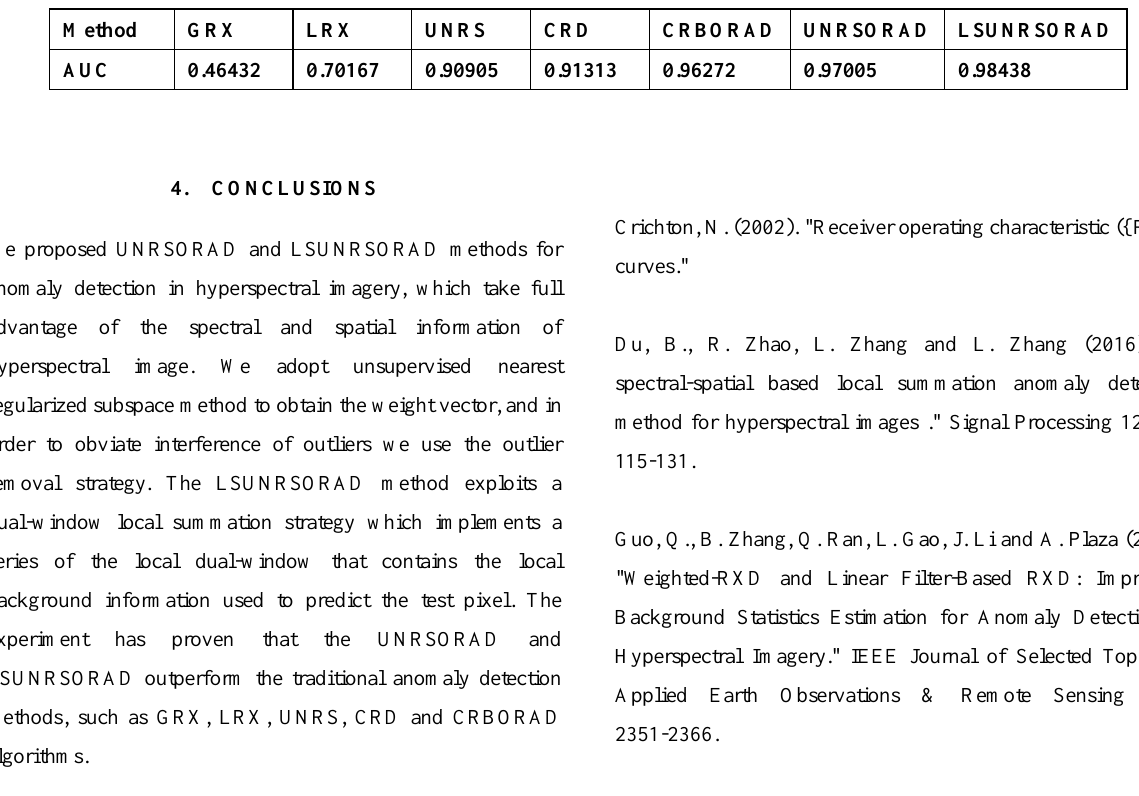
Fig. 6 ROC curves of different methods Table.1 AUC values of all the